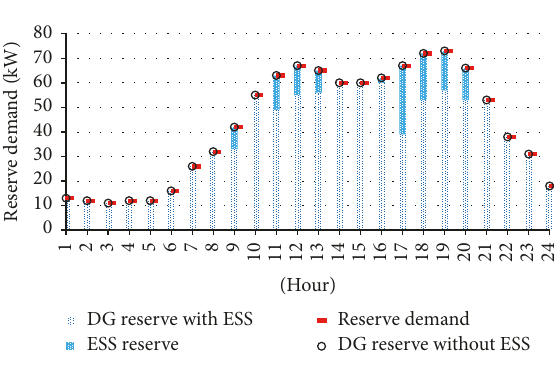
Figure 5: Reserve condition in Case 1.